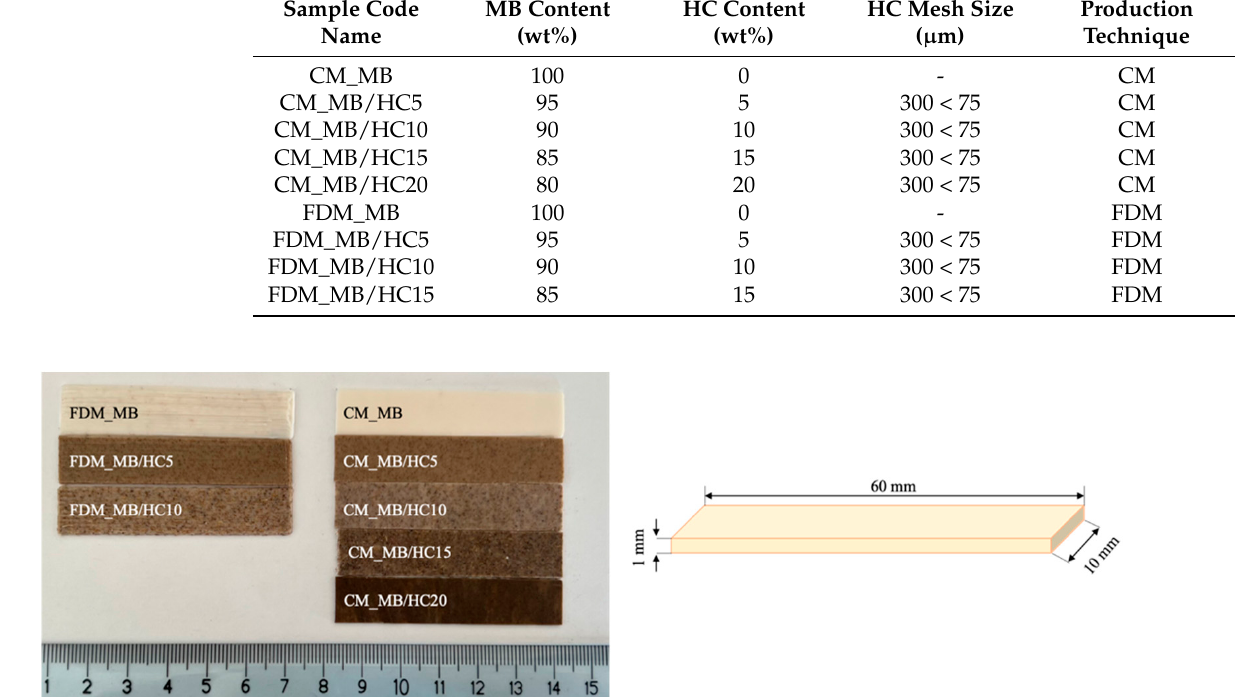
Table 2. Formulation of investigated samples.